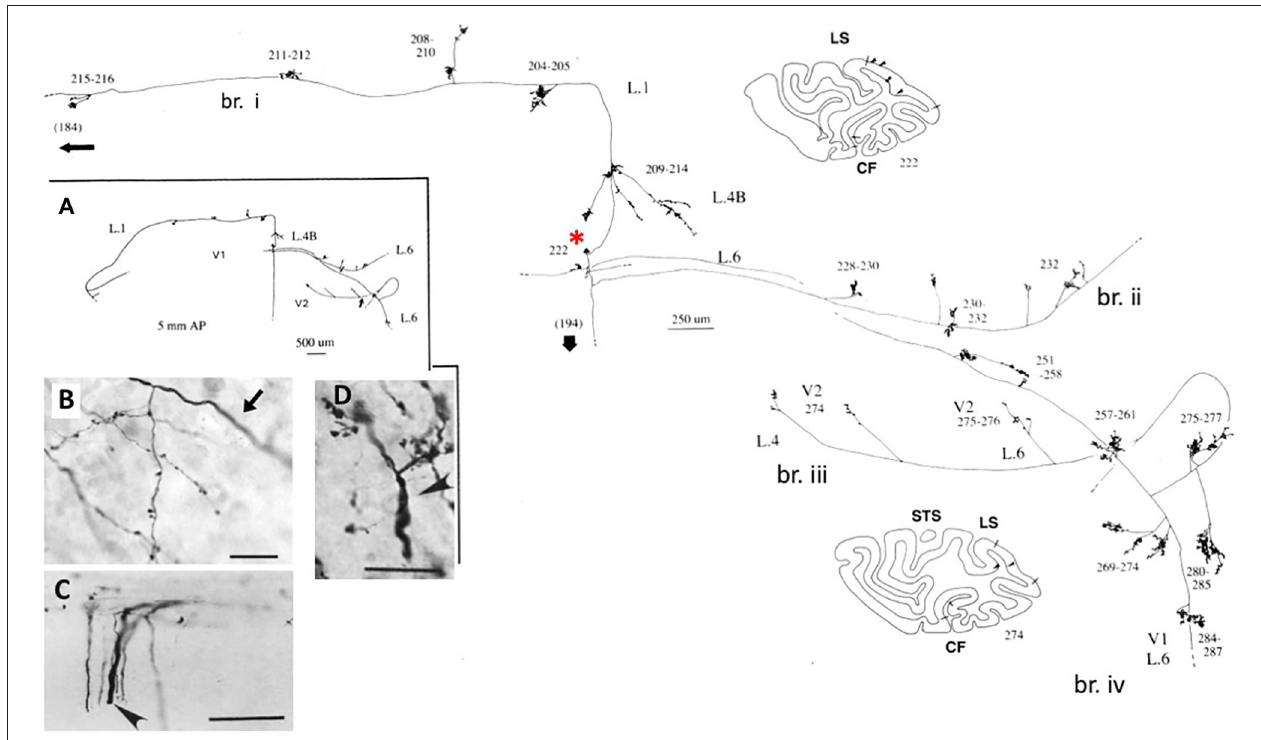
FIGURE 1 | A typical, spatially extended proximal axonal arborization of a Meynert cell (red asterisk) in primary visual cortex of a macaque monkey. There are three major intrinsic collaterals (labeled as br. i, ii, iv), extending 3.0mm dorsal in layer 1, 3.0mm ventral in layer 6, 4.0mm ventral in layer 6, and 0.5mm in layer 4B, as indicated by arrowheads in the two coronal section outlines (sections 222 and 274, where dorsal is to the left). All together, the intrinsic collaterals span 5.9mm anterior-posterior (117 sections × 50 µ m). A further, extrinsic collateral (br. iii) occurs in layers 4 and 6 of area V2. Portions of the individual collaterals and of the main axon (thick arrow) could not be followed, as is indicated by dashed lines. The low magnification inset ( A , at left) provides a schematic overview of the general configuration. Numbers denote individual sections, where 20 numbers = 1.0mm. All branches have numerous small synaptic clusters, one of which is illustrated in (B) . Note diminished diameter between the main axon (arrow) and the terminal arborization. Extrinsic axons (C) are of variable diameters (one large diameter axon at arrowhead). (D) Extrinsic terminations in area MT include some large diameter axons. Scale bar = 25 µ m in (B) , 100 µ m in (C) , 20 µ m in (D) . CF, calcarine fissure; LS, lunate sulcus; STS, superior temporal sulcus; L, layer. Modified from Figures 1, 9 in Rockland and Knutson (2001) and Figures 6f, 7b from Rockland (1995) with